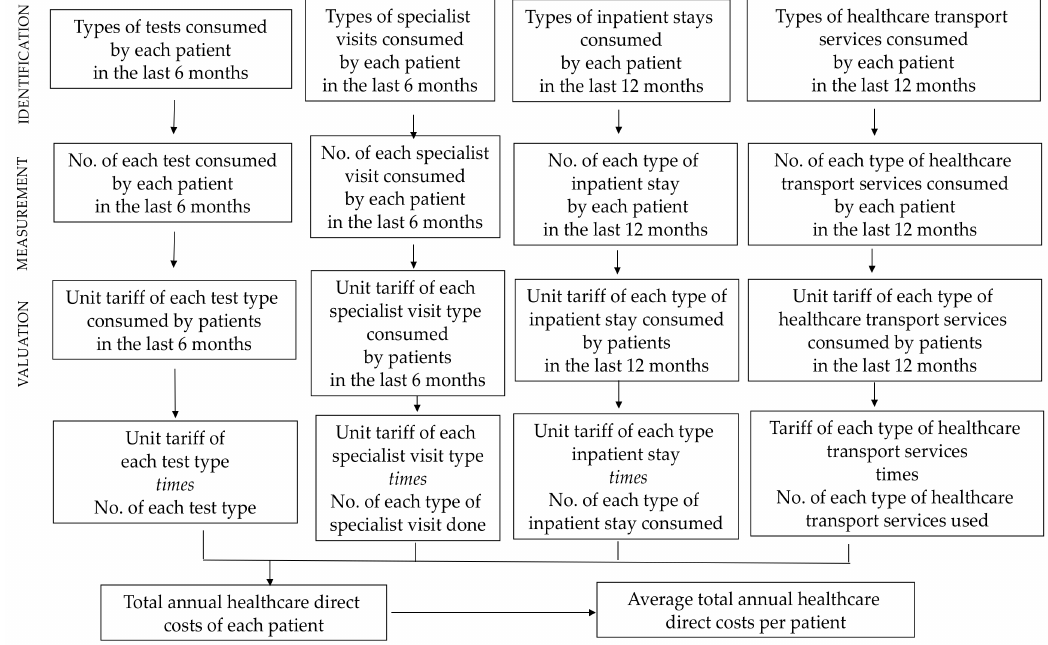
Figure 1. Description of the procedure implemented to estimate the average direct healthcare cost per patient according to micro-costing